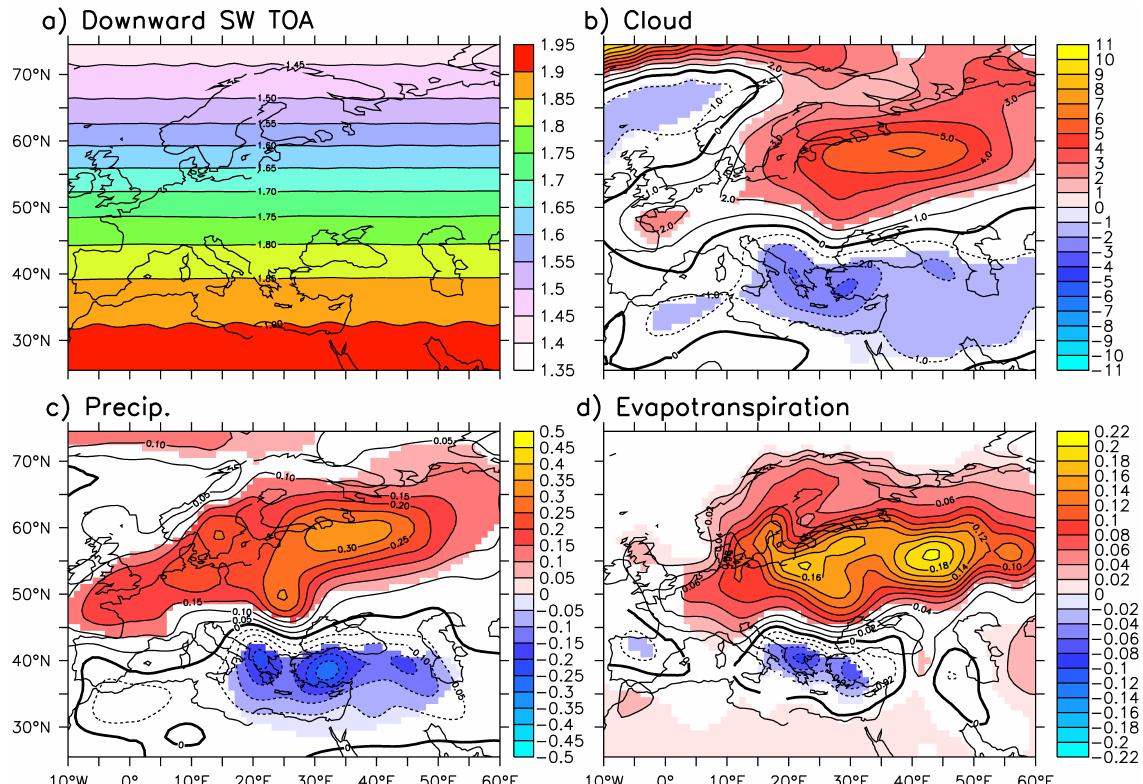
Fig. 3. Regression of different variables from the model simulation on the solar variations for the period 1001–1860. (a) Downward short- wave (SW) radiation at the top of the atmosphere (TOA) in Wm − 2 /Wm − 2 . (b) Cloud concentration in %/Wm − 2 . (c) Precipitation in mmday − 1 /Wm − 2 . (d) Evapotranspiration in mmday − 1 /Wm − 2 . The sign is positive for cloud, precipitation, evapotranspiration and down- ward SW when the variables increase with solar forcing. The shaded regions represent regions with statistically significant regression value at the 95% level.